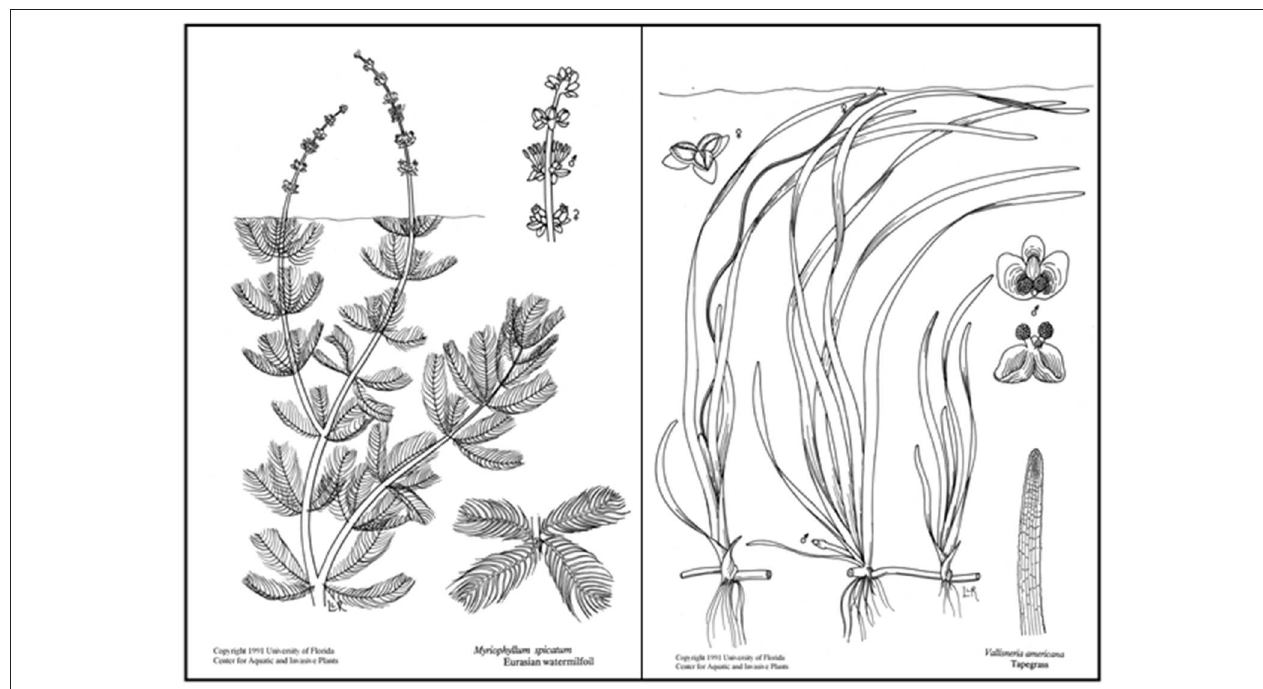
FIGURE 1 | SAV species compared in this study are the complex invasive species Myriophyllum spicatum (left) and structurally simpler native species Vallisneria americana (right) . Line drawings used with permission from UF/IFAS Center for Aquatic and Invasive